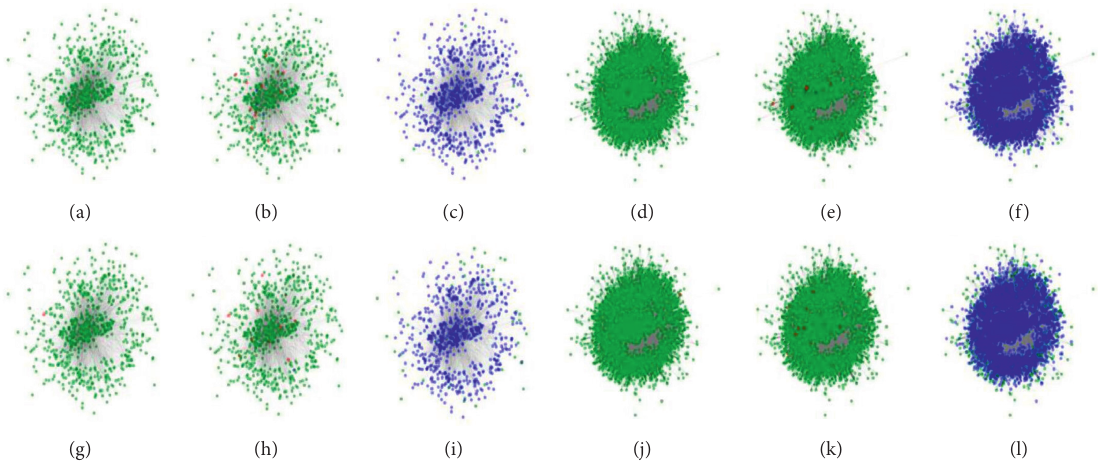
Figure 4: Node state on different time steps.